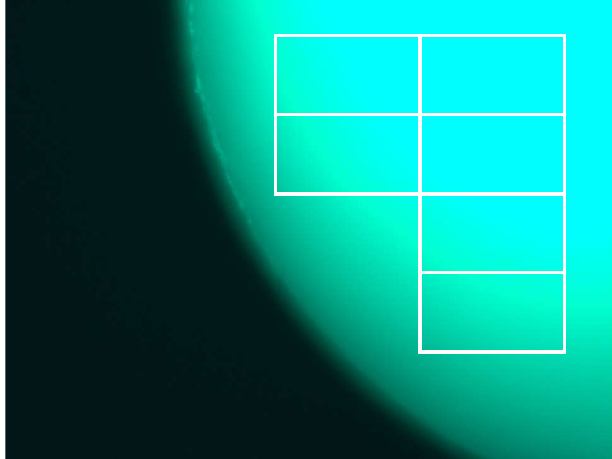
Figure 3. Fluorescent microscopic image of a single PP microplastic stained with Nile Red. The image was divided into six areas that were selected for analysis of fluorescent intensity.